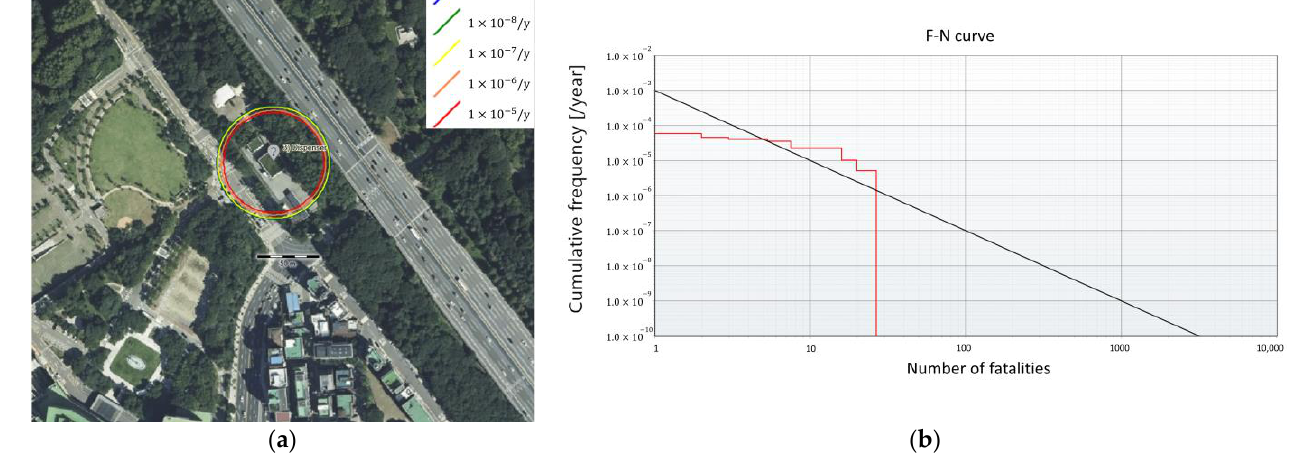
Figure 8. Risk assessment results for the GHRS system. ( a ) The risk analysis results and ( b ) the F-N curve.